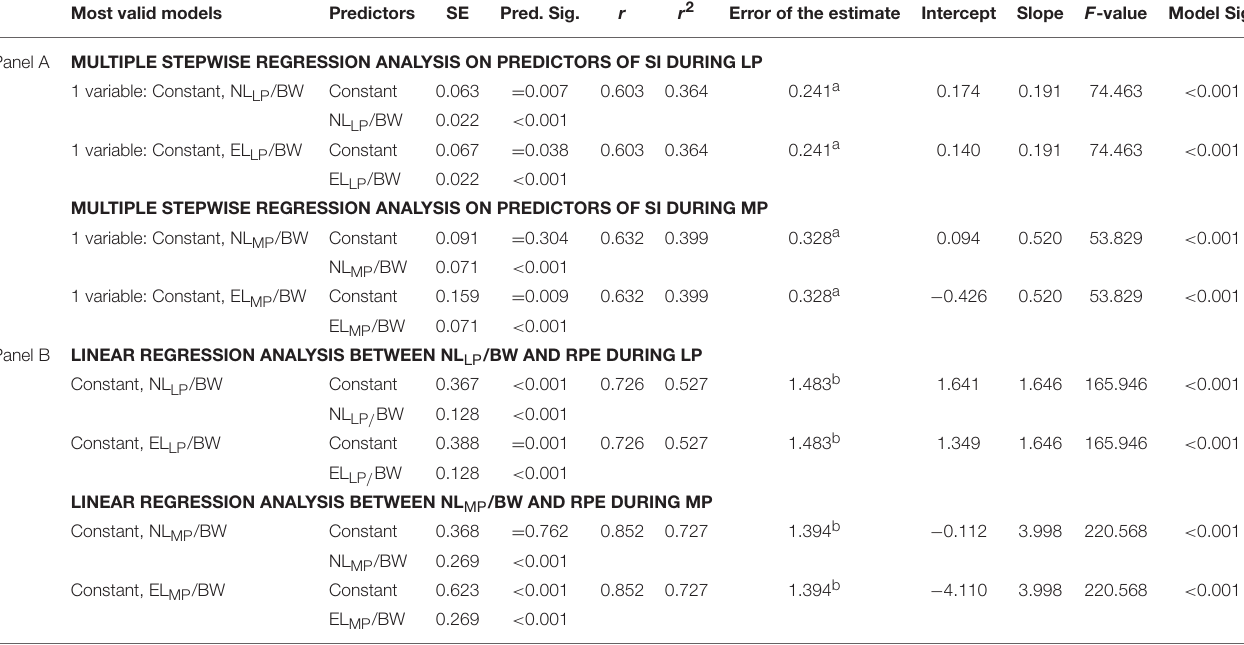
TABLE 2 | Multiple stepwise regression analyses for SI prediction (Panel A) and linear regression analyses on RPE (Panel B). Most valid models Predictors SE Pred. Sig. r r 2 Error of the estimate Intercept Slope F -value Model